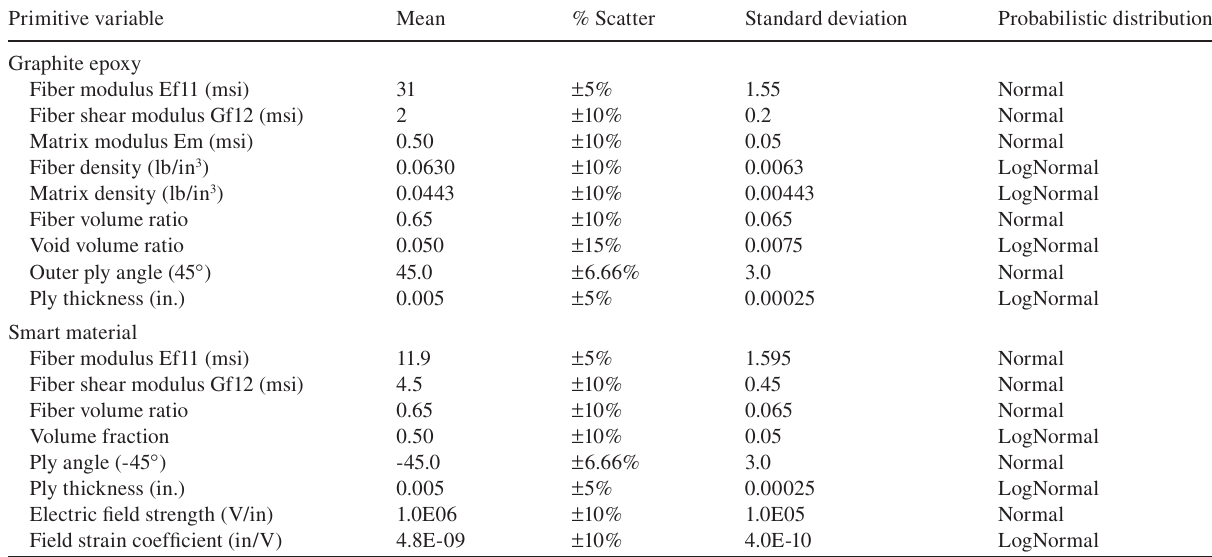
Table 1 Probabilistic dynamic buckling of a smart composite shell primitive variables, scatter, standard deviation and distribution. (1 psi = 6.9 paj; 1 lb = 4.445